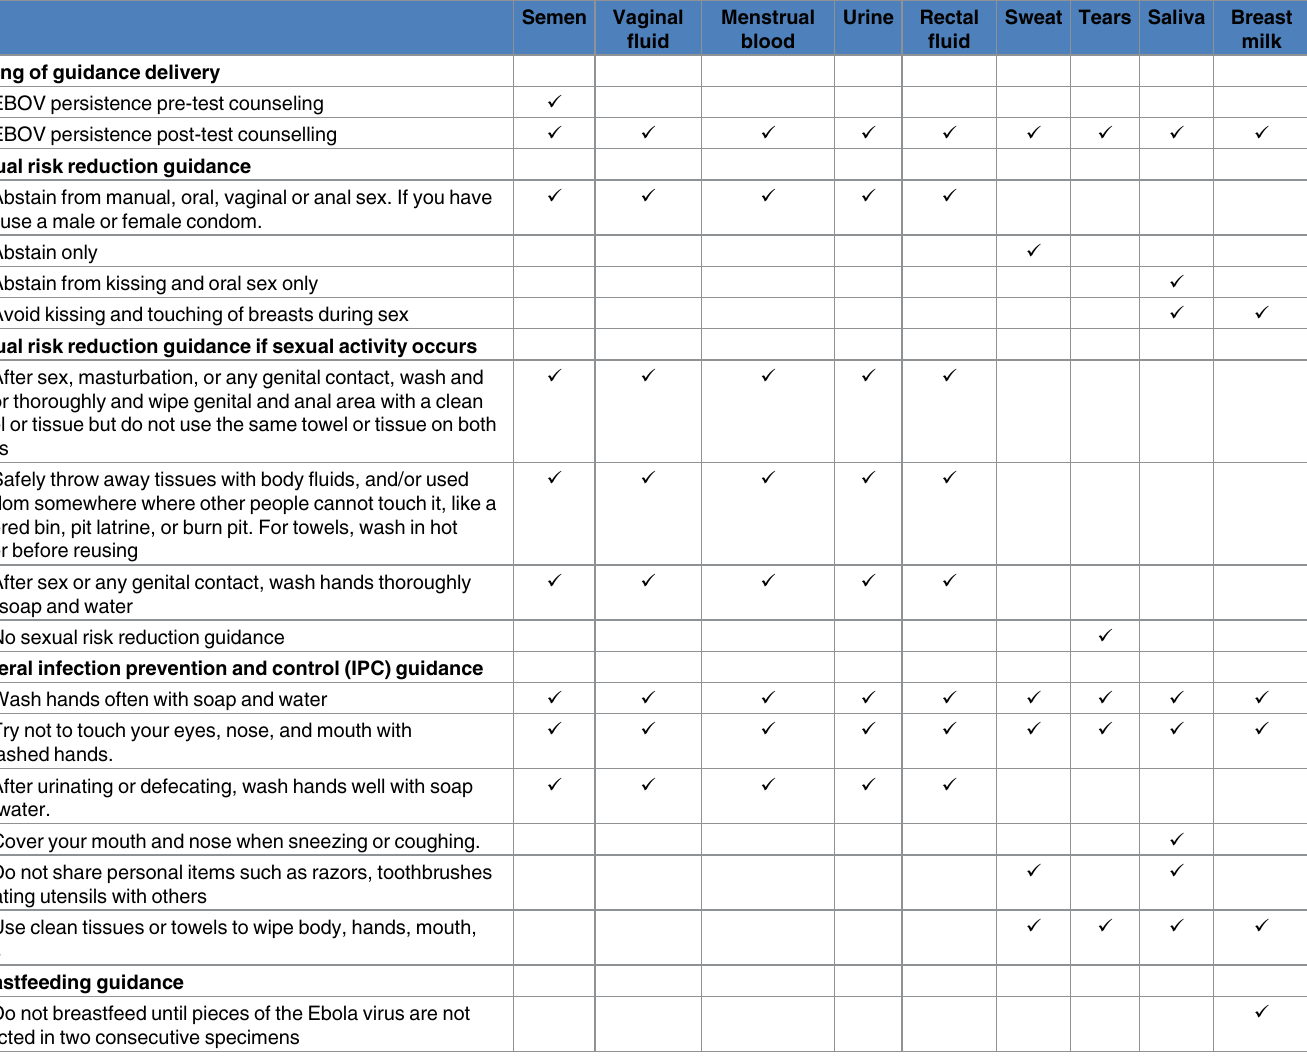
Table 1. Behavioral guidance for positive qRT-PCR test results on body fluid